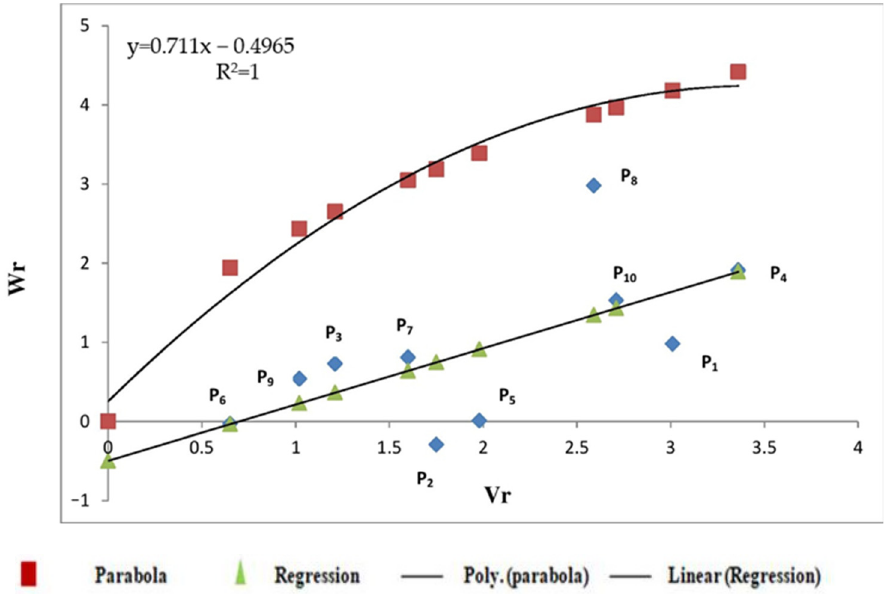
Figure 4. Wr–Vr graph for sedimentation value in E 2 . P1 = GW 451; P2 = GW 496; P3 = LOK 1; P4 = GW 322; P5 = GW 366; P6 = HI 1544; P7 = GW 173; P8 = GW 11; P9 = HD 2864; P10 = UAS 385. GW 451, LOK 1, GW 322, GW 11, HD 2864, and UAS 385 occupied intermediate positions on the regression line, indicating that dominant and recessive genes were equally distributed between them. Conversely, GW 496 and HI 1544 could be the carriers of genes causing an interallelic interaction because they occupied positions outside the truncated area of the graph (Figure 5).